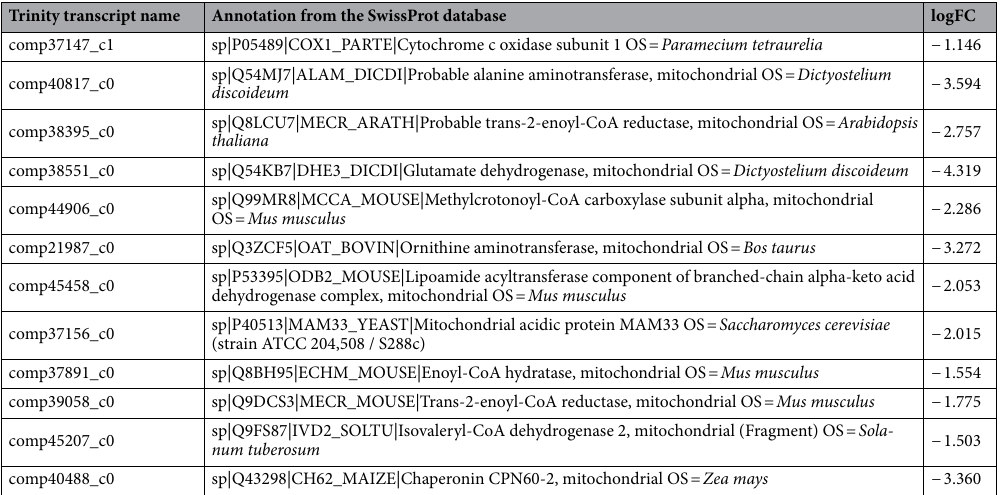
Table 1. Transcripts encoding mitochondria related protein in P. bursaria (from Kodama et al. 34